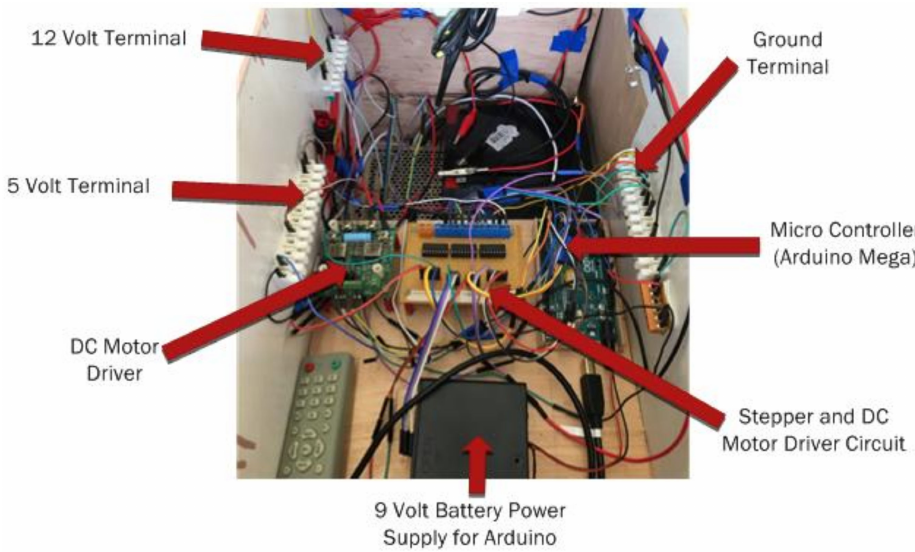
Figure 4. Controls and Power Circuit for multi-purpose smart farming robot. Table 4. Components and their power